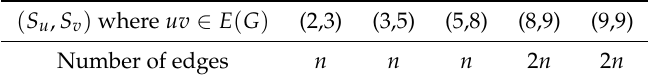
Table 4. The edge partition of the graph G for k = 2.